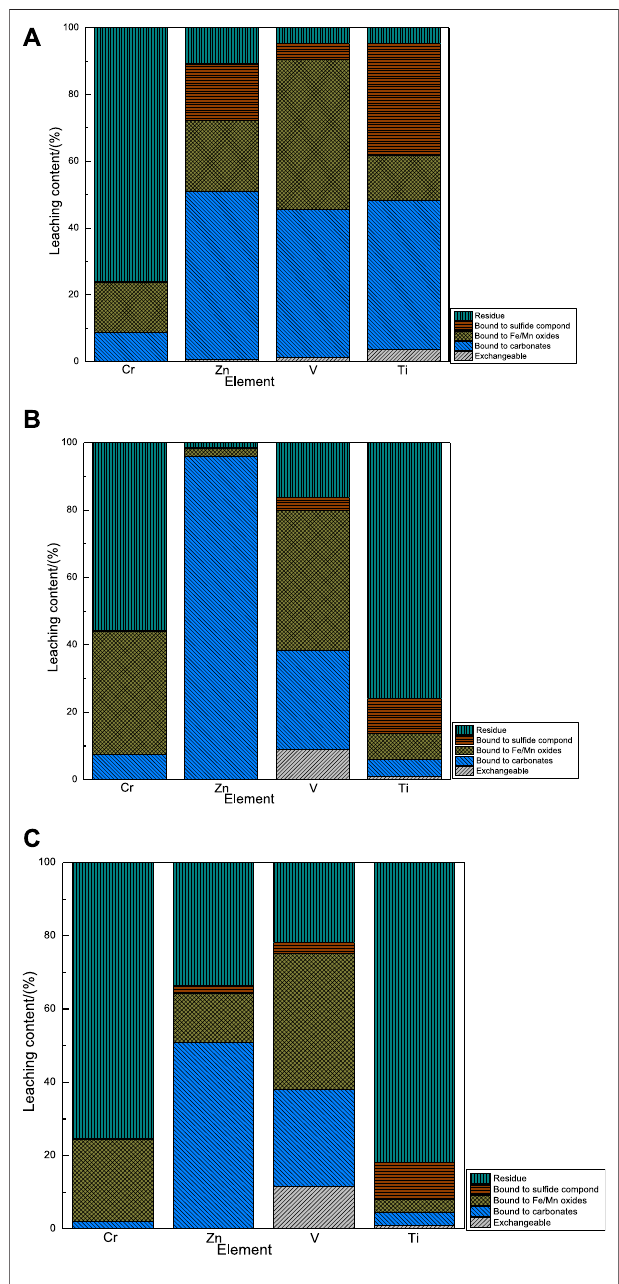
FIGURE 3 | Fraction of trace elements speciation of the uncarbonated area sample from A2A, carbonated area samples from A2C and C2C in 1d curingage. (A) the Cr, Zn, V, and Ti leaching content of A2A; (B) the Cr, Zn, V, andTileachingcontentofA2C; (C) theCr,Zn,V,andTileachingcontent of C2C.